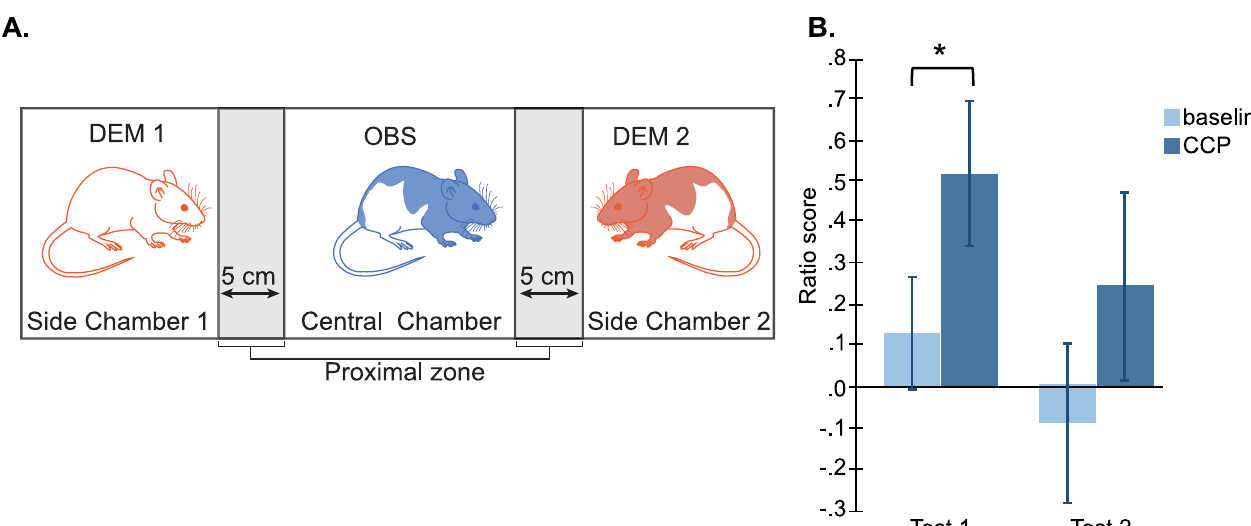
Fig 6. Same-strain recognition experiment. For this experiment, eight observers (OBS: all Long-Evans, four of which also served as demonstrators) and eight demonstrators (DEM; four Long-Evans and four Sprague Dawley rats) were used. (A) The test was conducted in a three-chamber testing box consisting of one large central chamber (L:72 cm × W:33 cm) and two small side chambers (each: L:27 cm × W:33 cm). The central chamber was separated from the side chambers by transparent perforated walls. The day prior to testing, all animals were habituated to the testing box. The test consisted of a 5-minute baseline period, in which observers were individually placed in the central compartment, followed by a 10-minute CPP, in which two unfamiliar demonstrators (DEM1 and DEM2: one Long-Evans and one Sprague Dawley rat) were simultaneously placed in one of the side compartments (placement was randomized). To avoid bias, the placement of the demonstrators occurred when the observer was in the center zone of the central compartment. Each observer had two tests, separated by an interval of 30 minutes to 1 hour, in which the location of the Sprague Dawley and Long-Evans rats was changed. The amount of time that the observers spent in the proximal zone during the initial 90 seconds of the baseline and CPP was scored, and a ratio score was estimated (difference in the time spent in the proximal zone of the Long-Evans rat and the time spent in the proximal zone of the Sprague Dawley rat divided by the sum of the time the observer spent in the proximal zone of the Long-Evans and Sprague Dawley rat. (B) Results show that, in test 1 and 2, observers spent more time in the proximal zone of the same- strain (Long-Evans) than of the different-strain (Sprague Dawley) demonstrator rats compared with baseline. This was significant for the first test of each trio (paired samples t test, test 1: t (6) = 2.58, p 2tail = 0.04; test 2: t (6) = 1.64, p 2tail = 0.15, � p < 0.05). Data can be found at http://dx.doi.org/10.17632/h8fkyr2z35.1. CCP, choice preference period; DEM, demonstrator rat; L, length; OBS, observer rat; W, width.